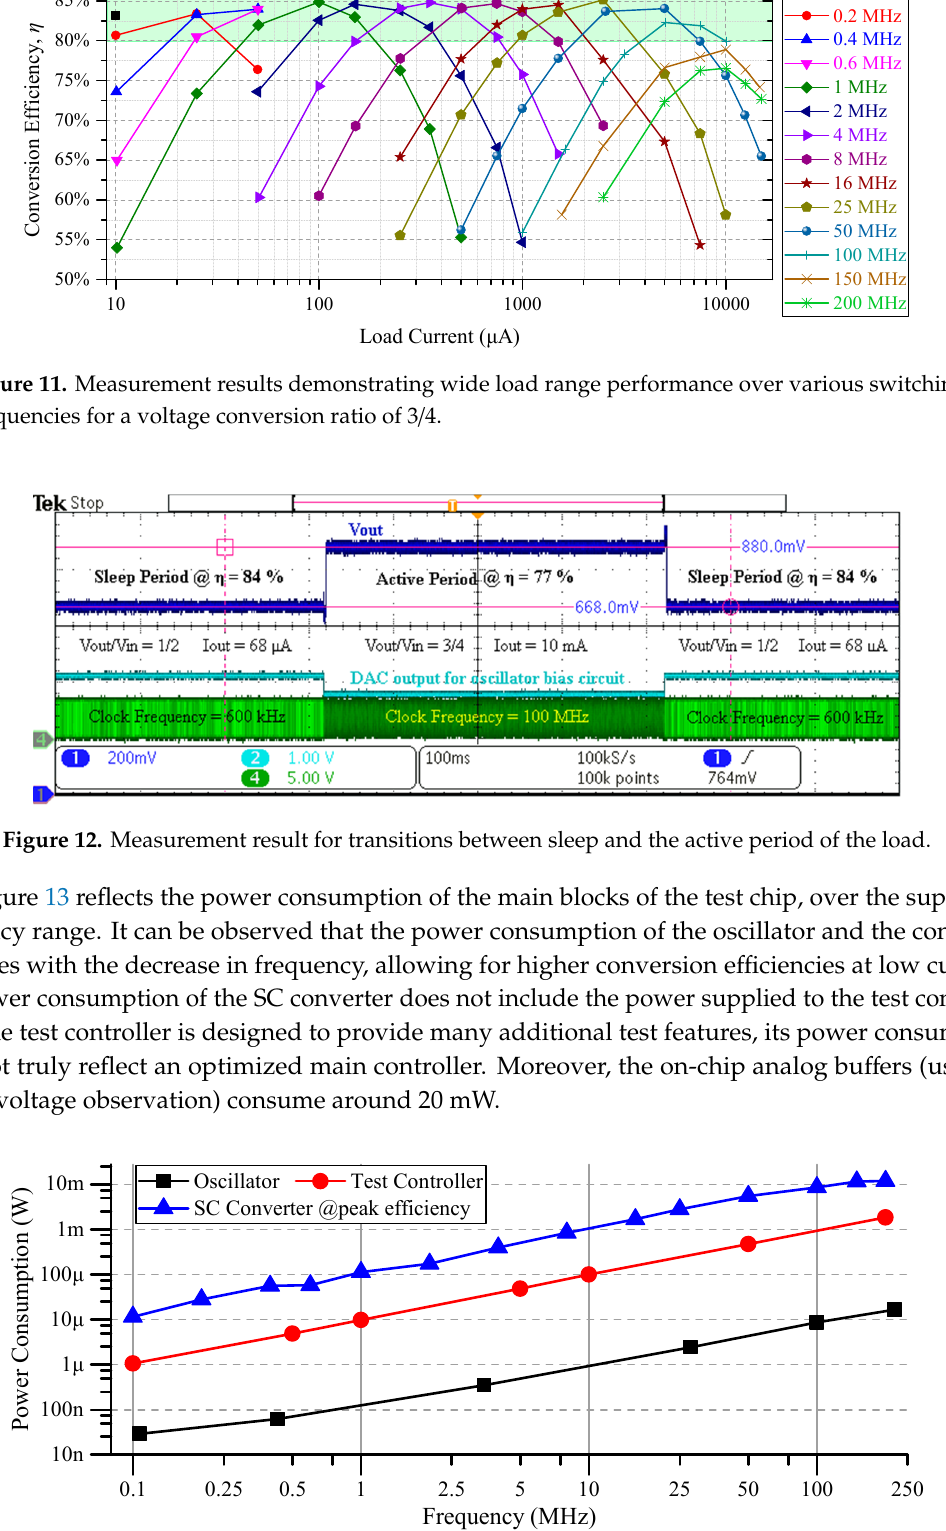
Figure 13. Test-chip power consumption at various operating